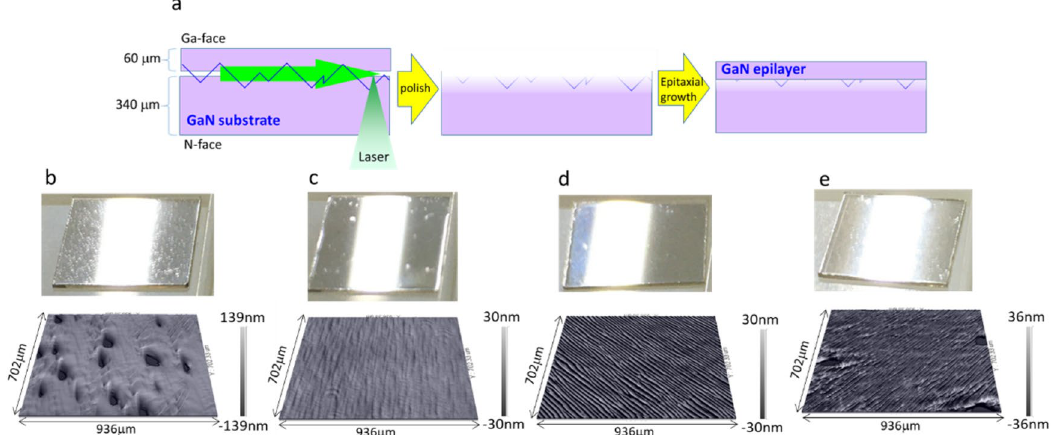
Figure 6. Photographs (upper) and white interference microscopy images (lower) of the samples after epitaxial growth. ( a ) Schematic image of experimental process. ( b ) Sample thinned by 18 µm. The arithmetic mean height of the area is 24 nm. ( c ) Sample thinned by of 47 µm. The arithmetic mean height of the area is 2.1 nm. ( d ) Sample thinned by 77 µm. The arithmetic mean height of the area is 7.2 nm. ( e ) Sample grown on commercially available epi-ready GaN substrate. The arithmetic mean height the of area is 8.0